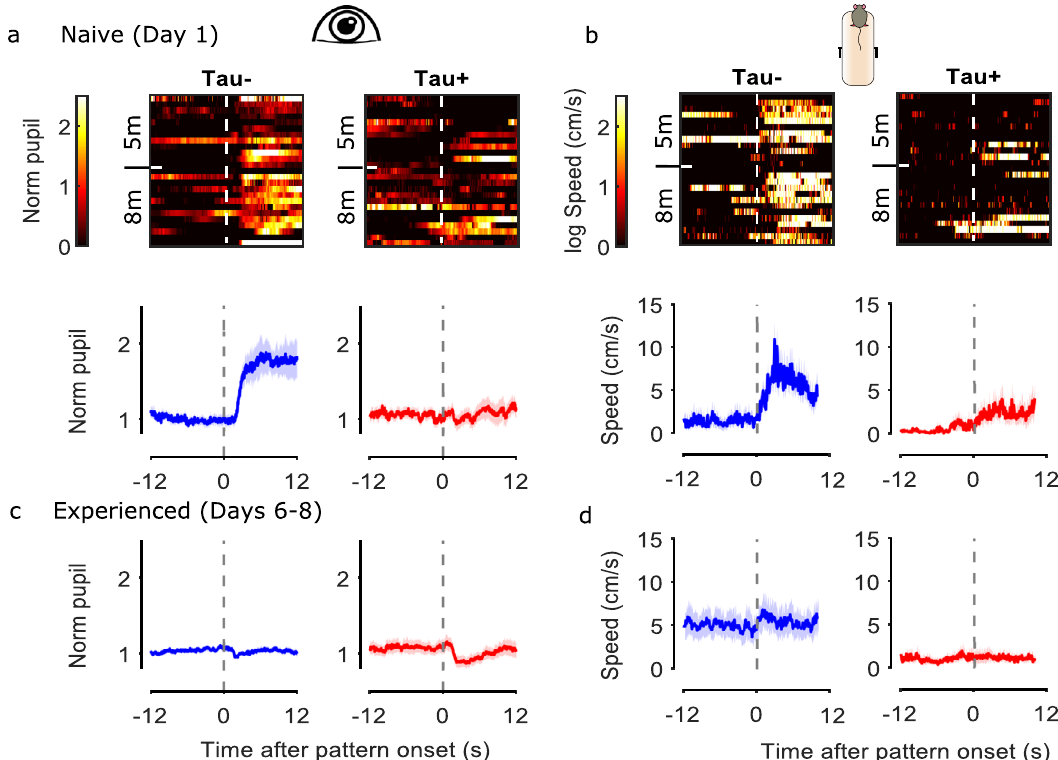
Fig. 6 Visual evoked behaviours are reduced in Tau + mice. a Top: Images of the normalised pupil responses to the onset of the stimulus of the fi rst block presented for naive animals (day 1; one animal per row). Pupil responses are normalised to the average pupil size during stationary epochs for 12 s before the stimulus onset where mice were viewing a grey screen. Bottom: Mean (±SEM) pupil responses for naive Tau − (blue, n = 25) and Tau + (red, n = 25) animals for both age groups. b Top: Images of the natural logarithm of movement speed responses to the onset of the stimulus for naive animals (day 1). Bottom: Mean (±SEM) movement speed for naive Tau − (blue, n = 25) and Tau + (red, n = 25) animals for both age groups. c , d Average normalised pupil responses and average movement speed to the onset of the stimulus for experienced animals (days 6 – 8). Horizontal dashed lines indicate the stimulus onset. Shaded areas represent the mean±SEM. The source data underlying this fi gure are available in Supplementary Data